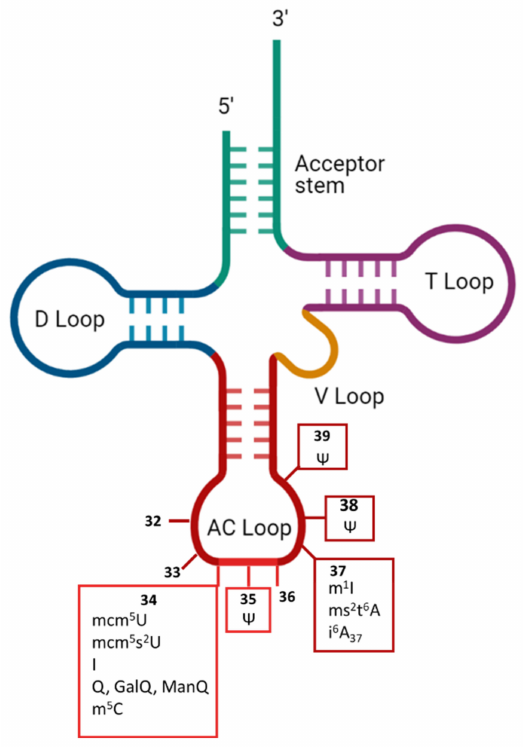
Figure 2. Overview of human cytosolic tRNAS anticodon loop modifications known to shape translation fidelity. AC loop: anticodon loop. Ψ : pseudo-uridine. I: inosine. m 1 I: N 1 -methylinosine. mcm 5 U: 5-methoxycarbonylmethyluridine. mcm 5 s 2 U: 5-methoxycarbonylmethyl-2-thiouridine. Q: queuosine. GalQ: galactosyl-queuosine. ManQ: mannosyl-queuosine. ms 2 t 6 A: 2-methylthio- N6-threonylcarbamoyladenosine. m 5 C: 5-methylcytosine. i 6 A: N6-isopentenyladenosine. 32–39: anticodon loop